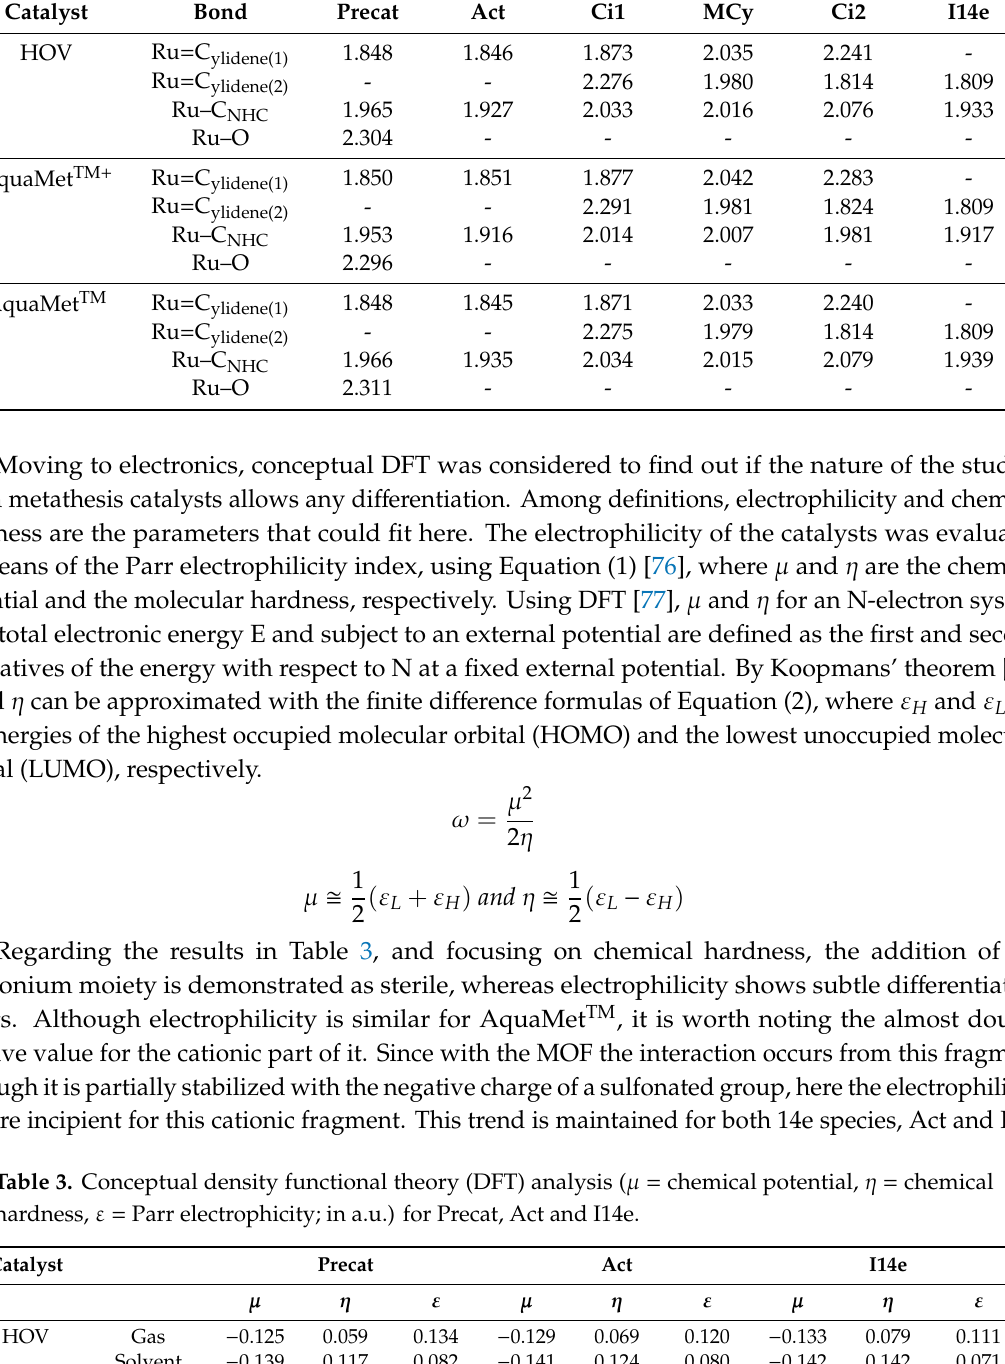
a ff ected. Table 4 gathers all the information related to natural bond orbital (NBO) charges. The charge on the ruthenium is the same for the first 14e species Act, but interestingly for the initial